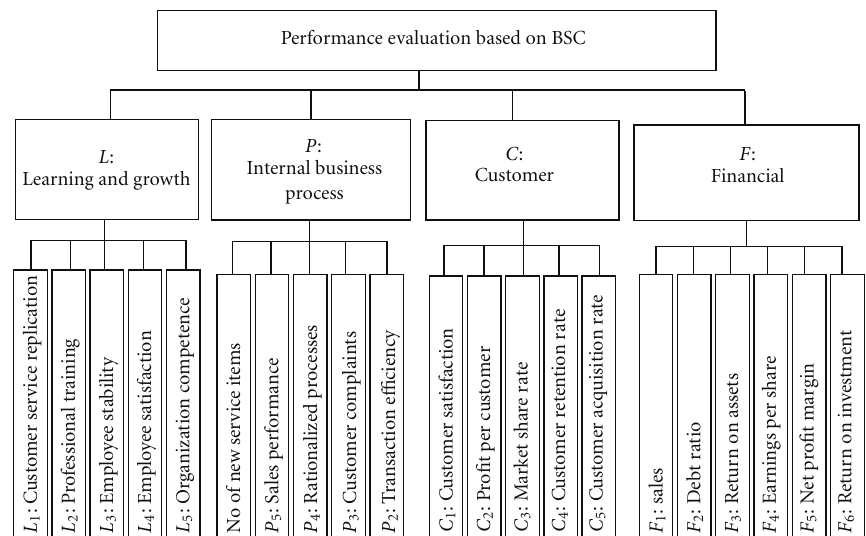
Figure 4: Membership function of linguistics variables for comparing two